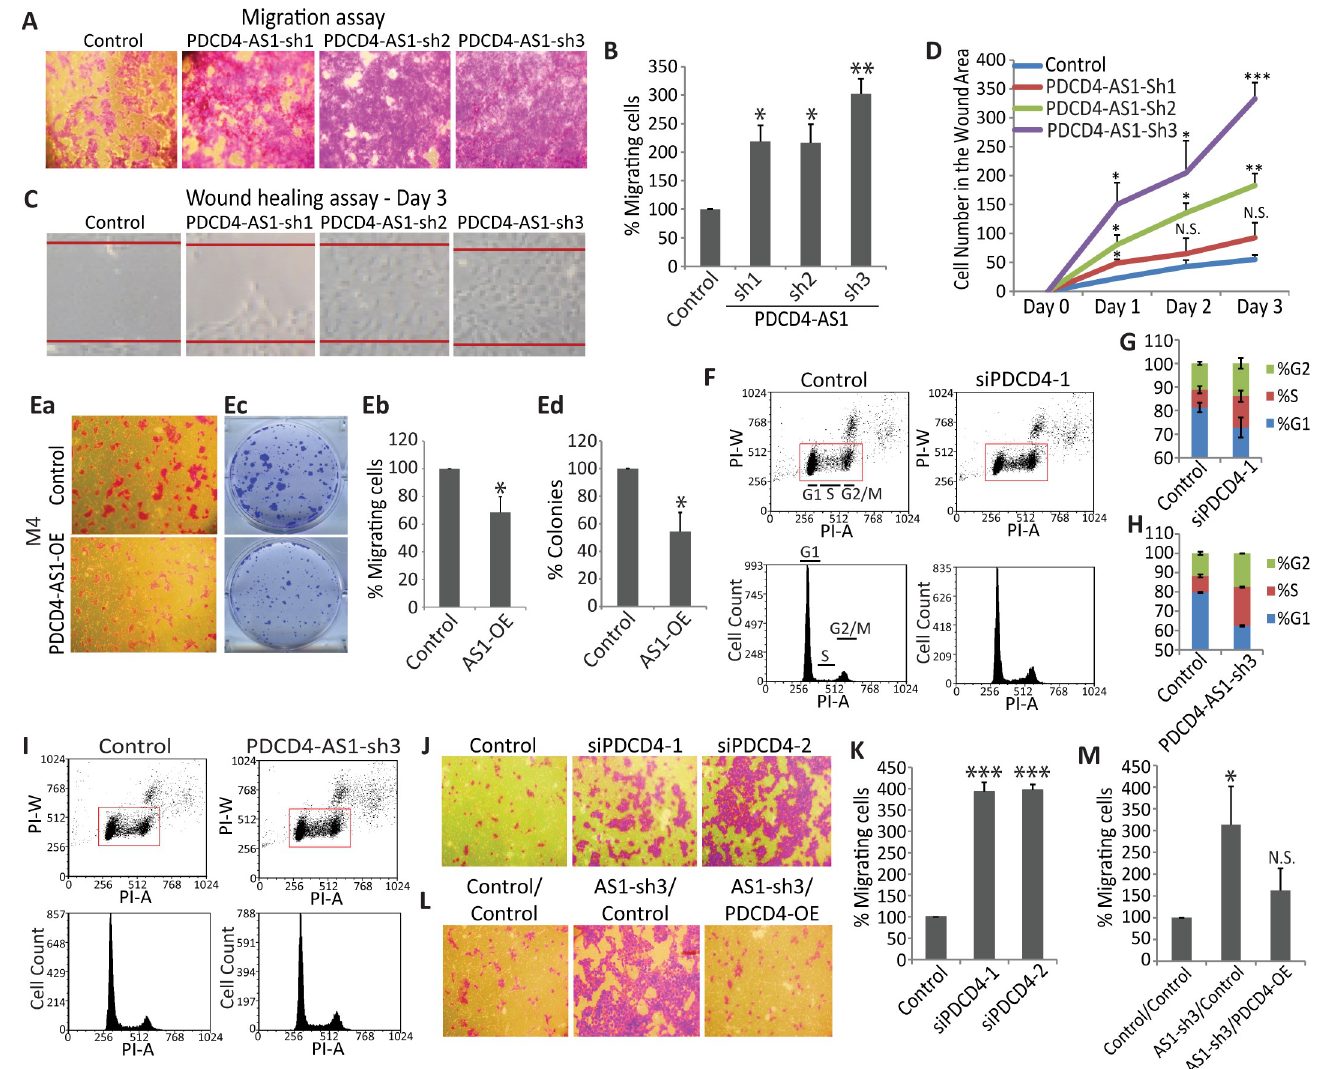
Fig 3. PDCD4-AS1 negatively regulates cell proliferation and migration. A-B) Transwell migration assay in control and PDCD4-AS1 -depleted M1 cells. C-D) Wound healing assay in control and PDCD4-AS1 depleted M1 cells. Images were taken at Day 0, 1, 2 and 3 after wound creation; the magnified image of Day 3 in control and PDCD4-AS1 depleted cells is shown in the figure C. Ea,b) Transwell migration assay in M4 cells that are overexpressing PDCD4-AS1 . Ec,d) Long-term anchorage-dependent plastic colony formation assay in M4 cells upon PDCD4-AS1 overexpression. F-G) Cell cycle flow cytometry in control and PDCD4- depleted M1 cells. H-I) Cell cycle flow cytometry in control and PDCD4-AS1 -depleted M1 cells. J-K) Transwell migration assay in control and PDCD4 -depleted M1 cells. L-M) Transwell migration assay in control and PDCD4 -overexpressing M1 cells that are depleted of PDCD4-AS1 (AS-sh3). Error bars in (B, D, Eb, Ed, G, H, K & M) represent mean ± SEM of N � 3 independent experiments (biological replicates). � P < 0.05, �� P < 0.01 and ��� P < 0.001 using Student’s t test. NS depicts not significant results.